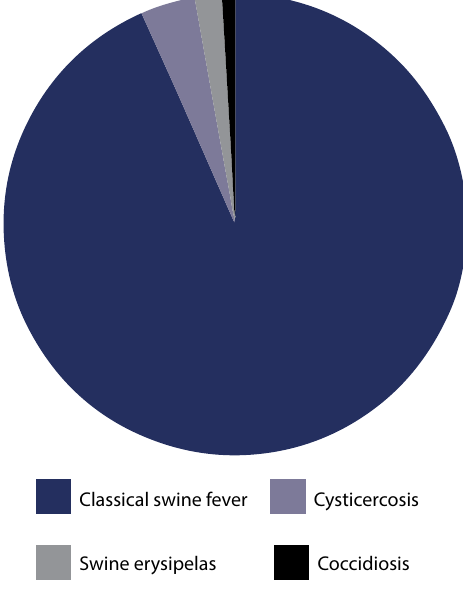
Figure 4: Frequency of reported pig diseases in the national database (DALRRD) from 1999 to 2019: classical swine fever (99 outbreaks); cysticercosis (4 outbreaks); swine erysipelas (2 outbreaks) and coccidiosis